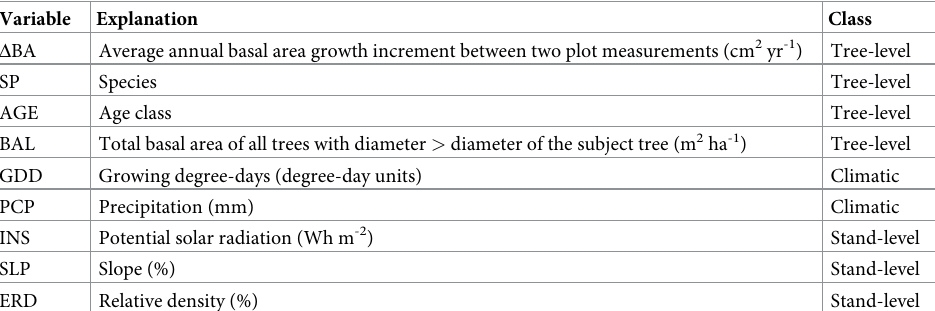
Table 3. Listing of independent variables for tree rate of mortality